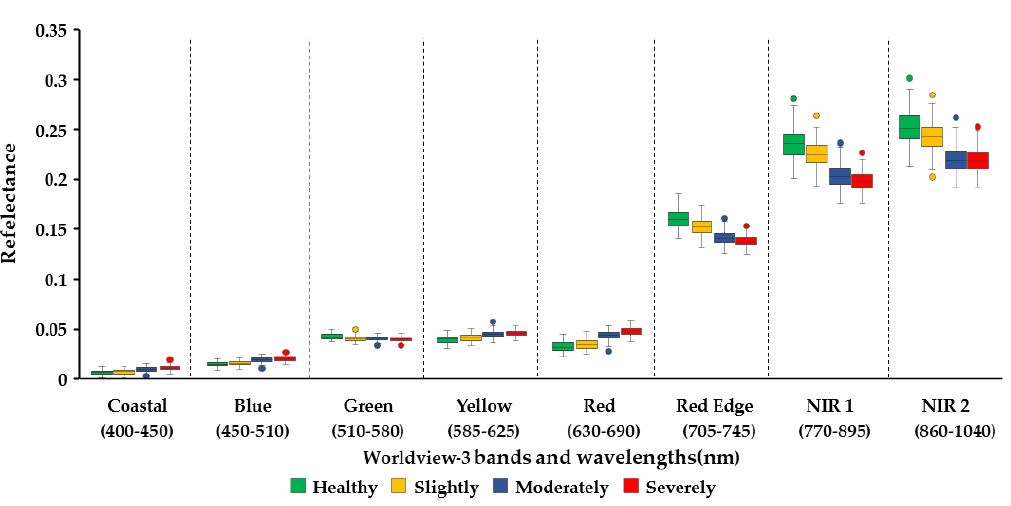
Figure 5. Reflectance values of the four damage levels “healthy”, “slightly”, “moderately”, and “severely” based on the WV-3 image.